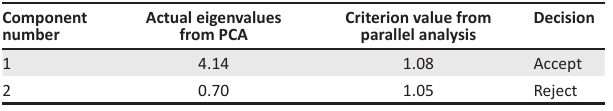
PCA, Principal component analysis. TABLE 4: Correlations (Pearson’s) between the items of 7-item servant leadership questionnaire as well as the descriptive statistics and communalities of the items. Tolerance